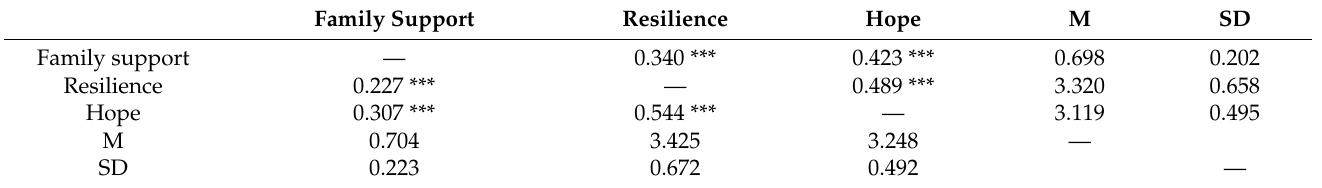
Table 3. Correlation analysis of family support, resilience, and hope for relapsers and non-relapsers. Family